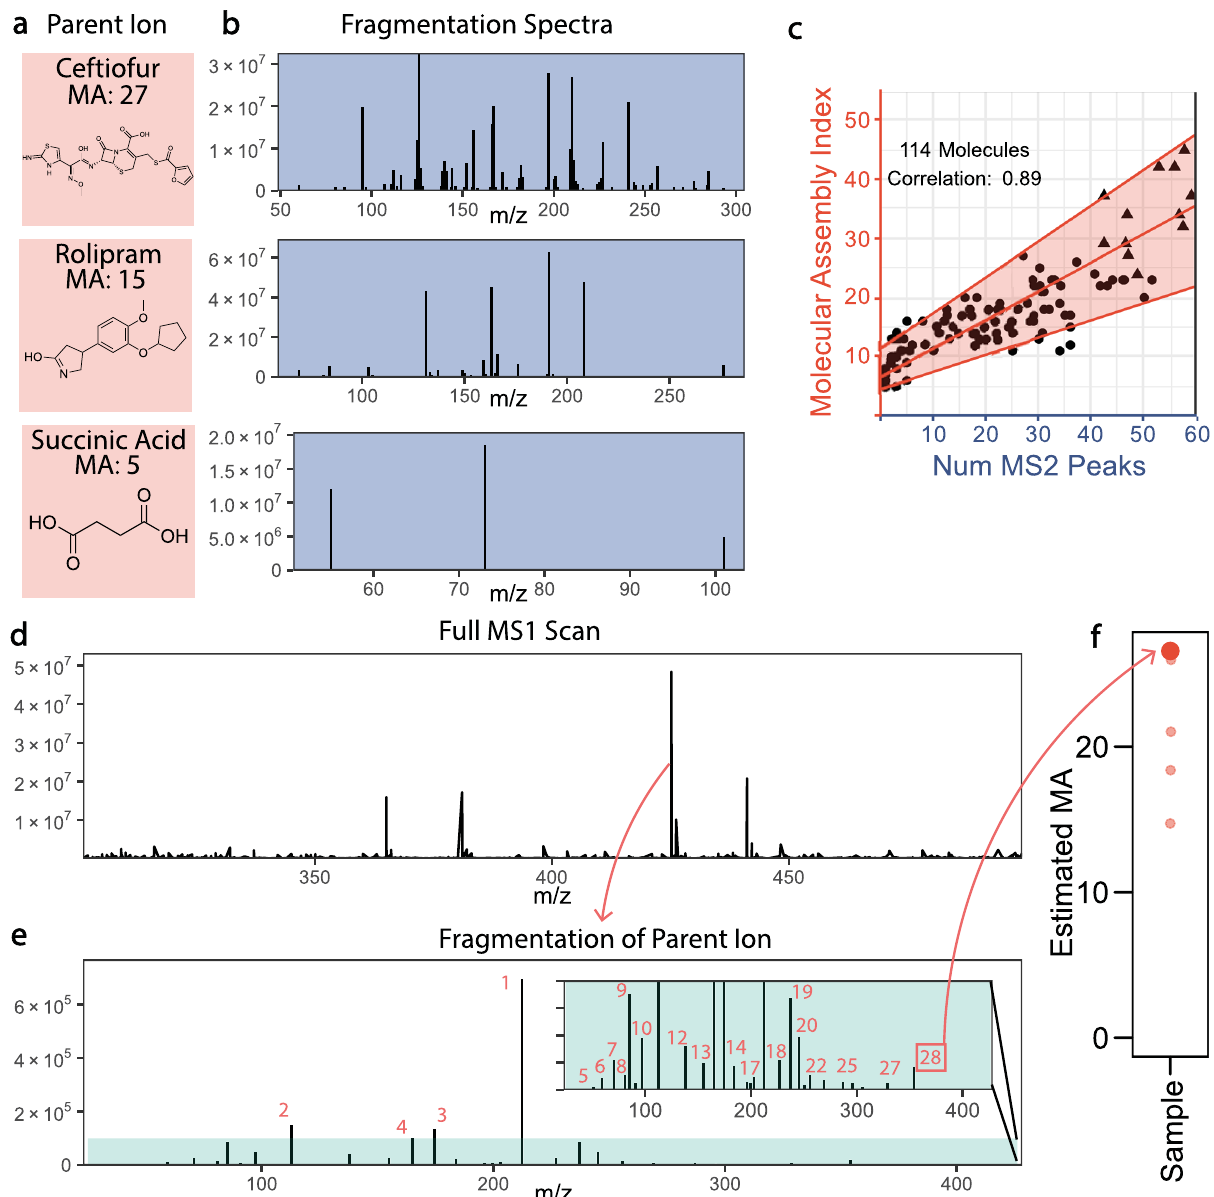
Fig. 3 Experimental correlation of mass spectrometry data to MA and MA analysis of mixtures. a Three example molecular structures with associated MA index. b The fragmentation spectra associated with the molecular ions from (A). The high MA molecules have more peaks in their fragmentation spectra. c The observed correlation between the number of peaks in a fragmentation spectrum and the MA value of the ion, the shaded region shows the 90% prediction interval using quantile regression, with the median prediction shown in the center line. The circles represent small organics while triangles represent peptides. D-F indicate analytical work fl ow for measuring MA in mixtures. d A single ion is selected based on intensity. e MS2 spectra from the selected ion, with the inset showing the same spectra zoomed in on the shaded region to show lower intensity peaks. The total number of peaks in the fragmentation spectra are counted to correlate with the MA. f Many ions from the mixture will be fragmented and the predicted MA from that sample form a distribution, we consider the highest MA value measured to represent the MA of the